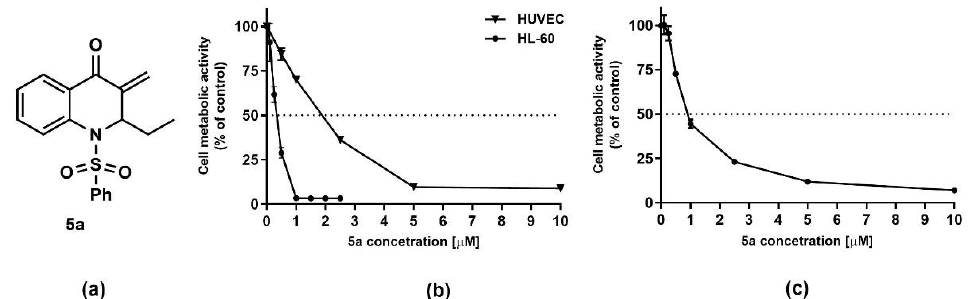
Figure 2. Structure of the selected compound 5a ( a ). Metabolic activity of ( b ) HL-60 and HUVEC cells treated with various concentrations of 5a for 48 h; ( c ) HL-60 cells treated with various concentration of 5a for 24 h, measured by MTT assay.